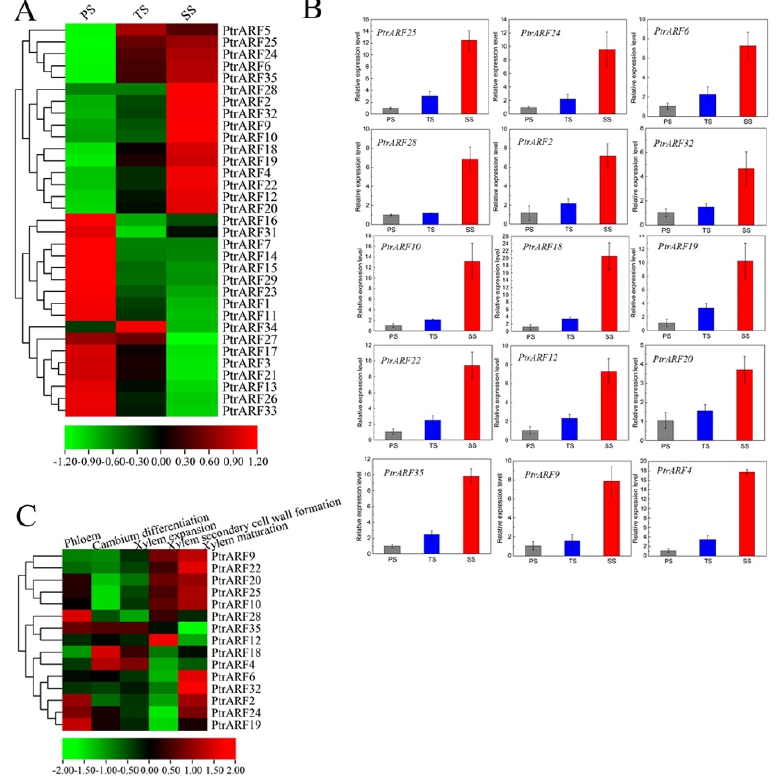
Figure 7. The expression patterns of PtrARF genes during wood formation. ( A ) Expression patterns of 35 PtrARF genes in primary stems (PS), transitional stems (TS), and secondary stems (SS) tissues in RNA-seq; ( B ) the expression level of 15 PtrARF genes in PS, TS, and SS of poplar using qRT-PCR assay. The expression levels of each gene were calculated in relevance to corresponding gene expression PS. Error bars represent standard deviation of biologic replicates. ( C ) The expression patterns of 15 PtrARF genes were obtained from AspWood RNAseq dataset during different phases of wood formation.